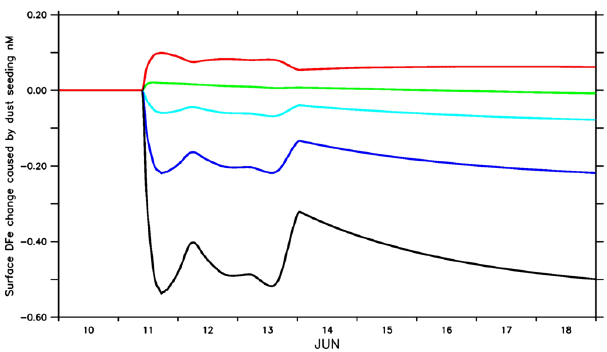
Fig. 11. Sensitivity study with respect to initial DFe concentration before dust addition. Surface DFe change caused by dust addition is calculated as the difference of surface DFe concentration with and without dust addition and plotted for different initial DFe concen- trations: 2.0 (black), 1.0 (blue), 0.5 (light blue), 0.25 (green) and 0µmolm − 3